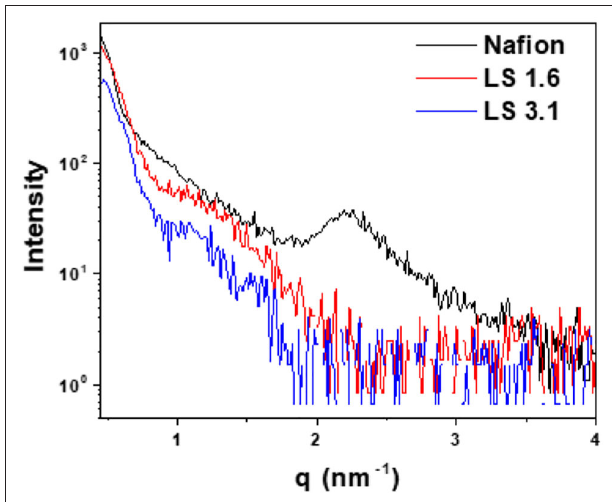
FIGURE 5 | In-plane RSAXS profiles of LS 1.6 (Cs + form), and LS 3.1 (Cs + -form) films on n-SiO 2 wafers at 60%